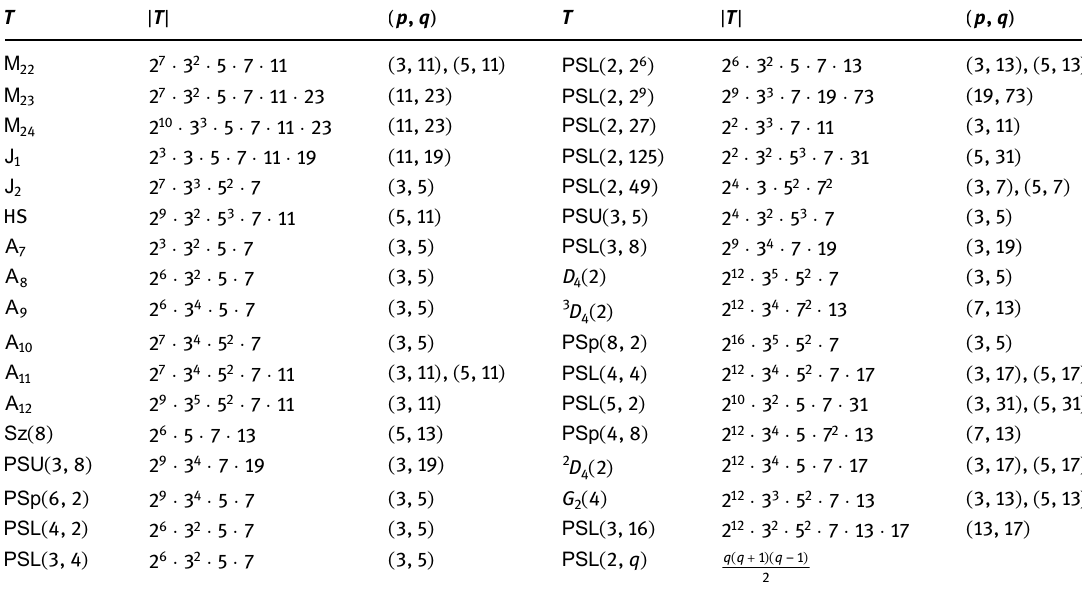
Table 3: Simple group T with order